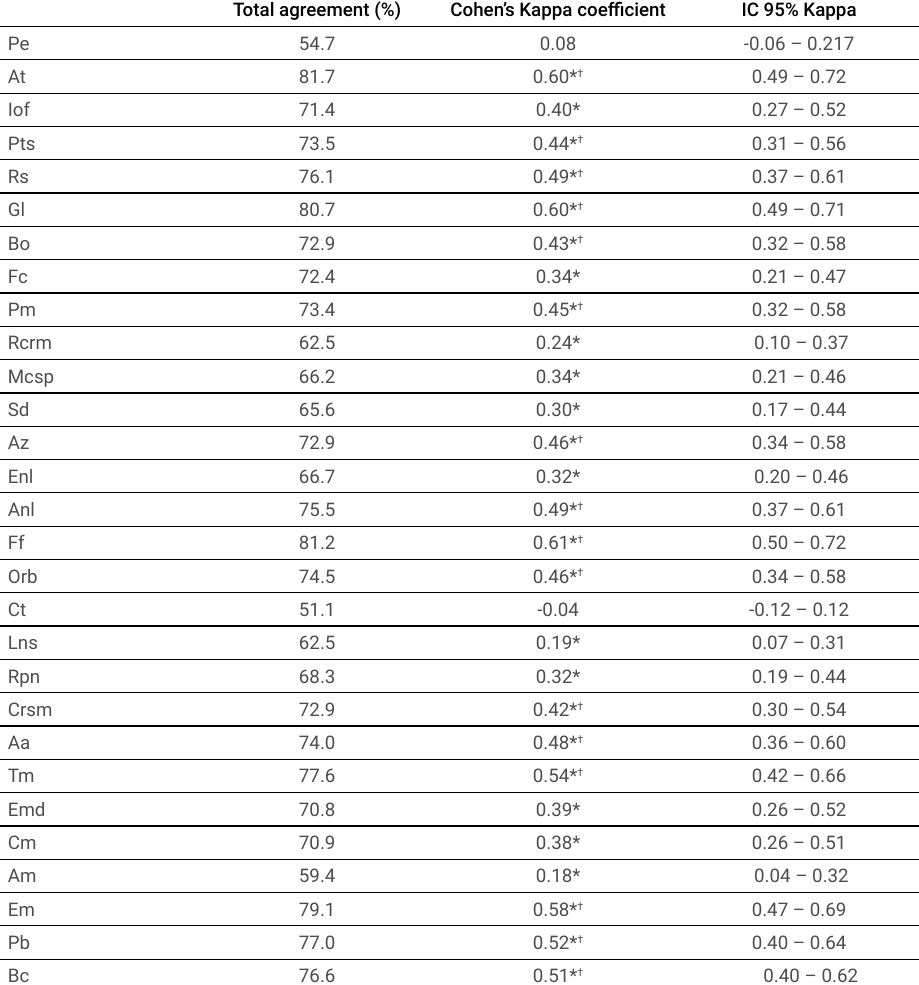
Table 4. Percentage of total agreement, Cohen’s kappa coefficient and 95% CI kappa of variables in relation to actual sex. Total agreement (%) Cohen’s Kappa coefficient IC 95% Kappa